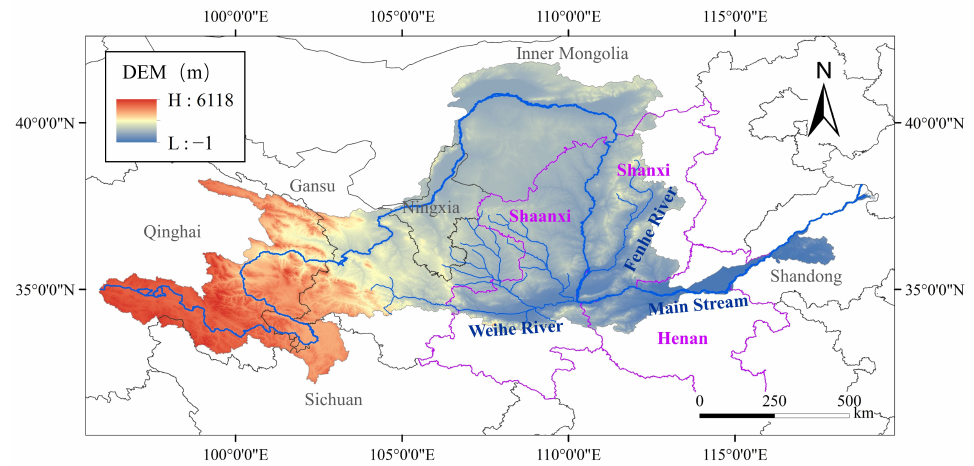
Figure 1. Geographical map of the Yellow River